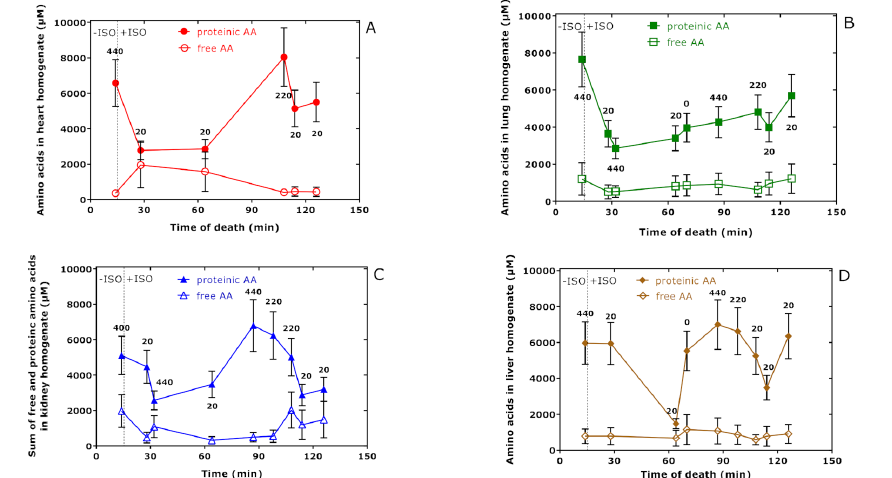
Figure 3. Sum of tissue-free and proteinic amino acid (AA) concentrations in heart ( A ), lung ( B ), kidney ( C ), and liver ( D ) of rats administered with the indicated hArg doses at time = 0 min and sacrificed at the indicated time points. Data are presented as the mean ± SEM. The vertical dotted lines indicate the time point of isoprenaline (ISO) injection at t = 15